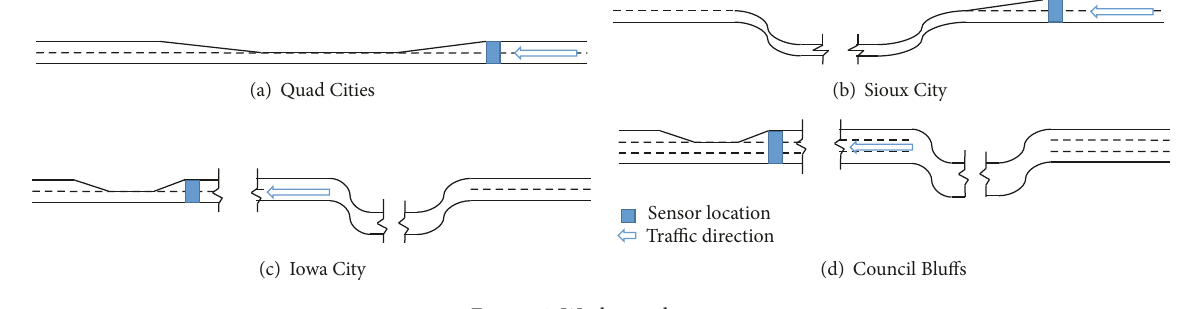
Figure 1: Work zone